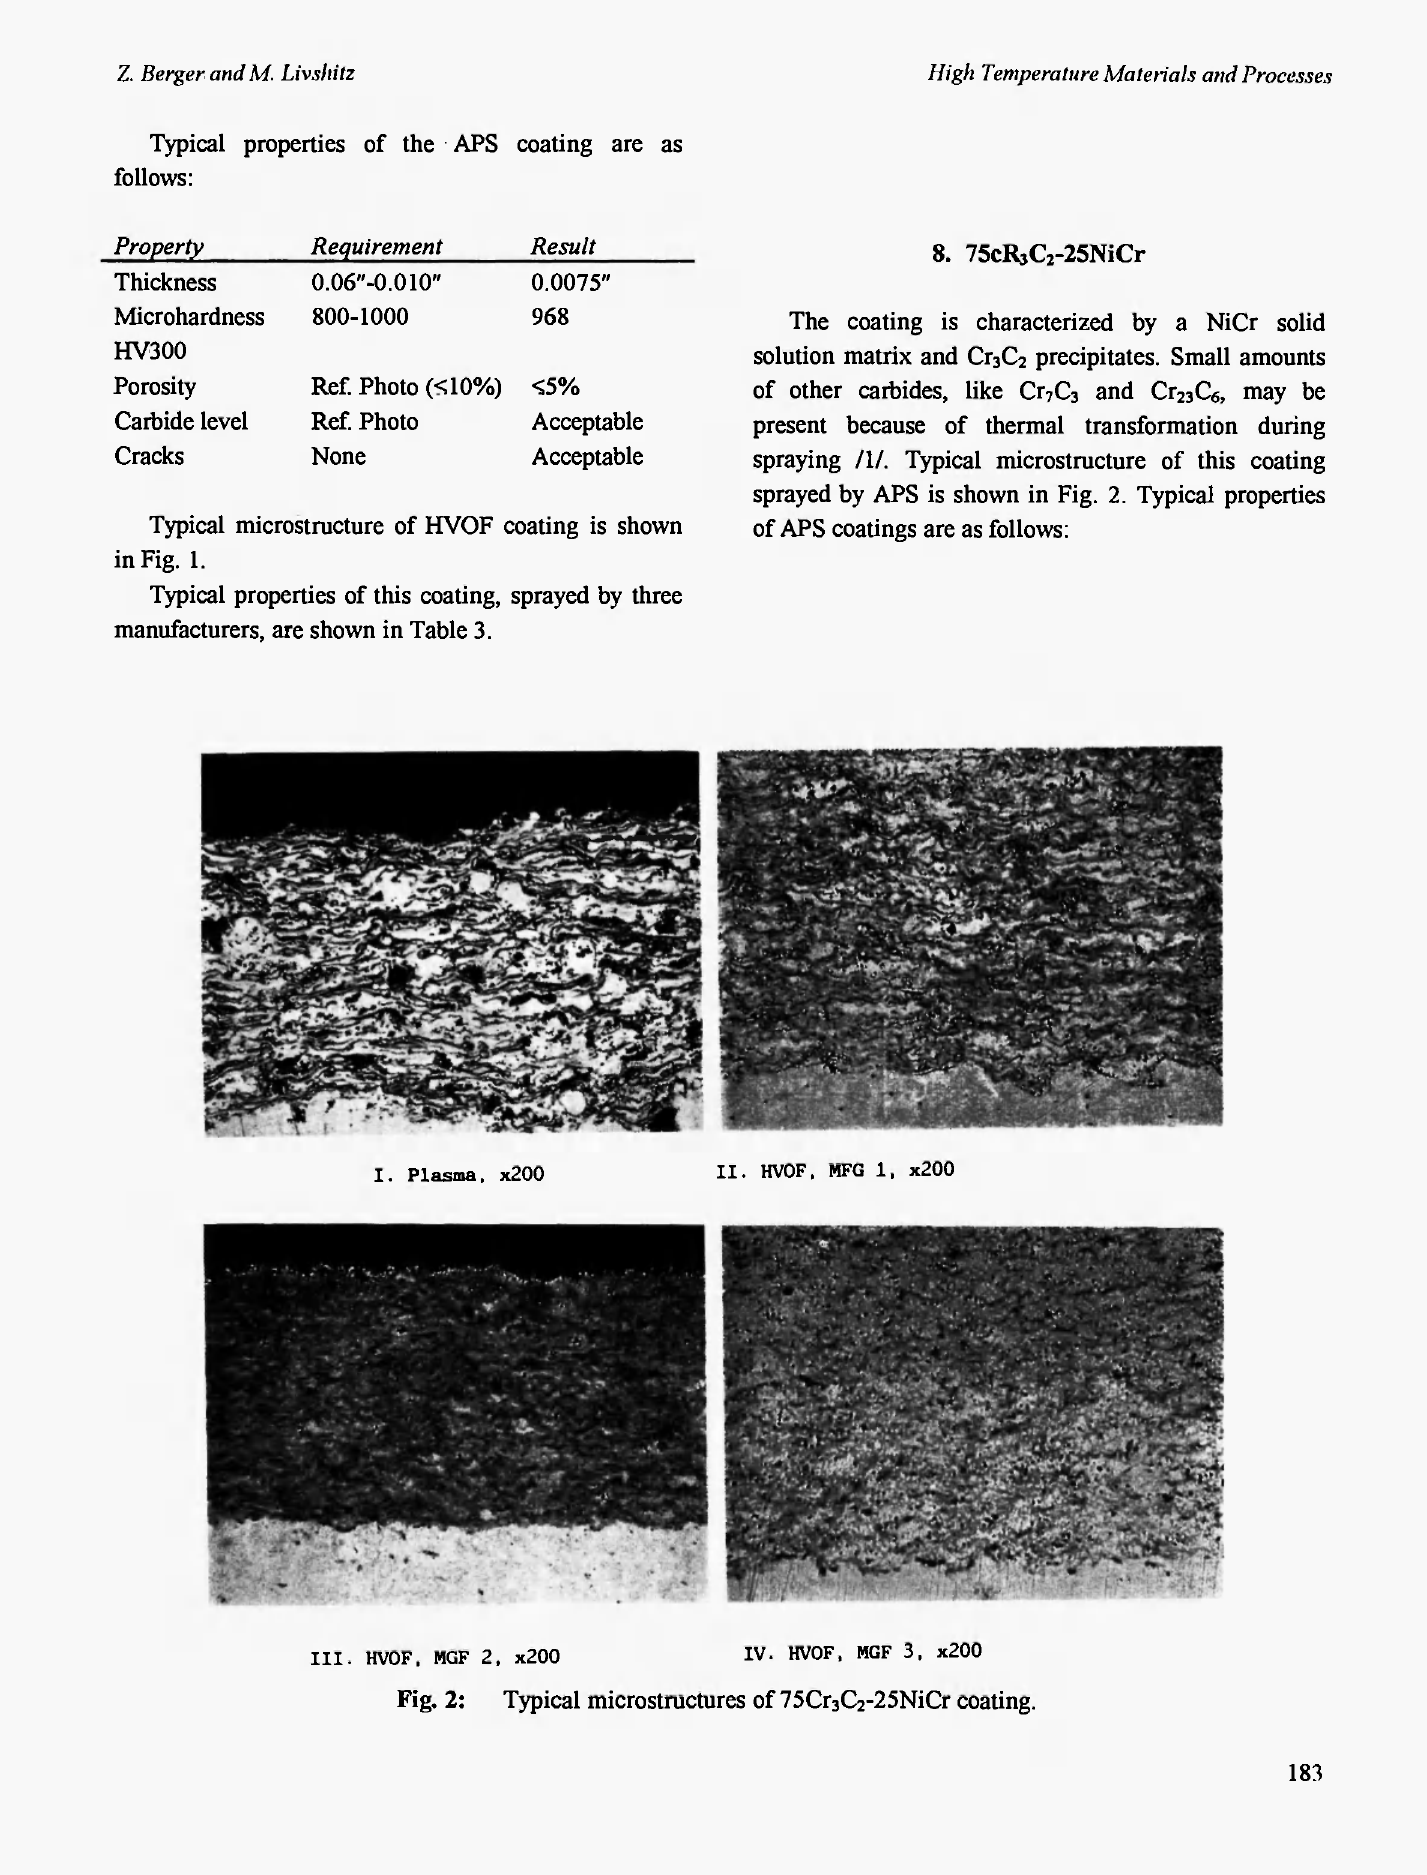
Fig. 2: Typical microstructures of 75Cr